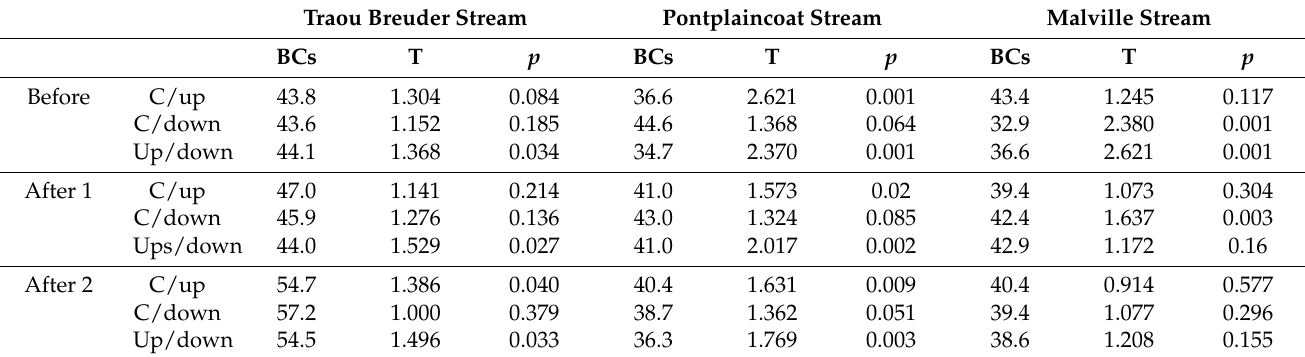
Table 4. Results of PERMONAVAs on the Bray–Curtis similarities (BCs) between macroinvertebrate communities before and after restoration (Before: before restoration; after1: first year of monitoring after restoration; after2: second year of monitoring after restoration; C = Control site; up = upstream section and down = downstream